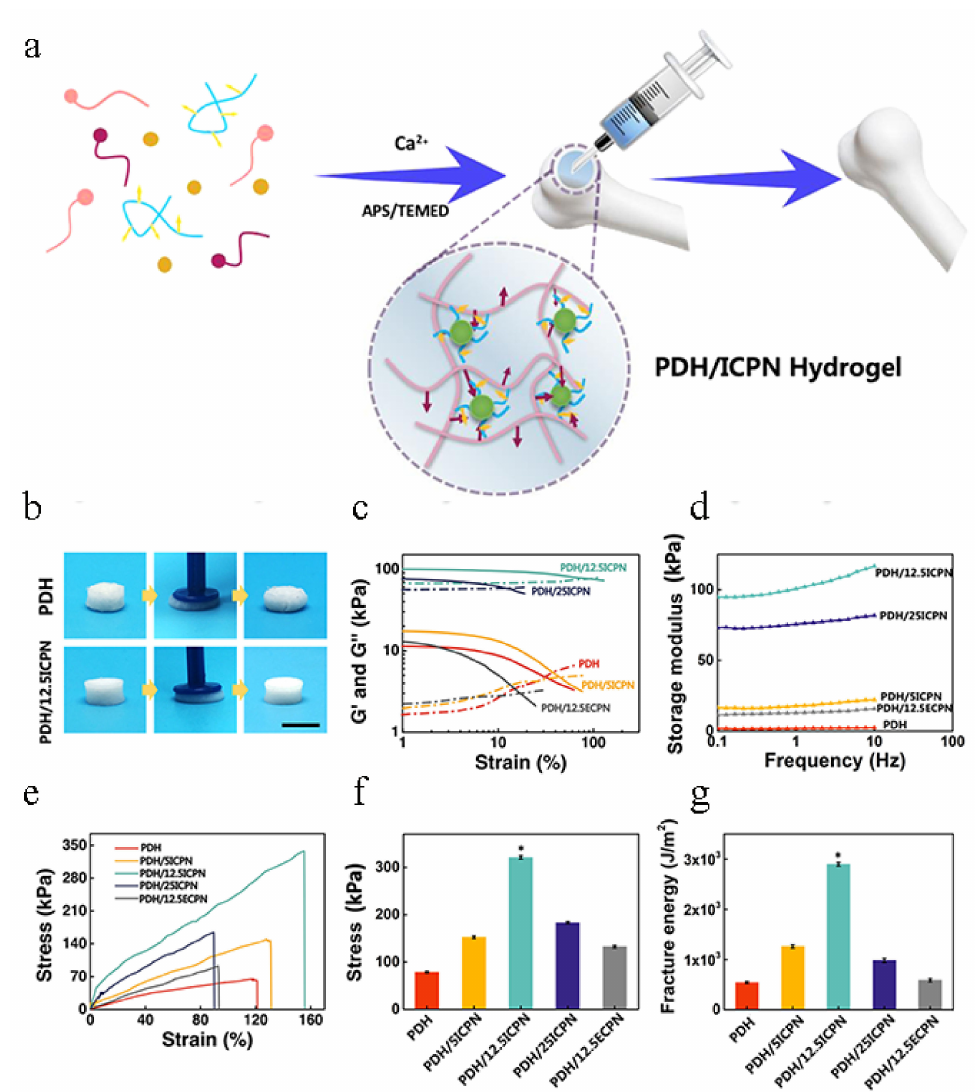
Figure 3. ( a ) Schematic illustration of the fabrication of the injectable PDH/ICPN hydrogel for bone regeneration. ( b ) Optical images of the PDH and PDH/12.5ICPN nanocomposite hydrogels under excessive compression (scar bar: 1 cm). ( c ) Strain- dependent ( ω = 10 rad/s) (solid lines represent G (cid:48) and dashed line represent G”) and ( d ) frequency-dependent (at a strain of 1%) oscillatory rheological analysis results. ( e ) Stress-strain curves of the nanocomposite hydrogels with different calcium phosphate (CaP) contents. ( f ) Fracture stress and ( g ) fracture energy of PDH, PDH/mICPN, and PDH/12.5ECPN hydrogels (“*”: p < 0.05, indicating significant differences)